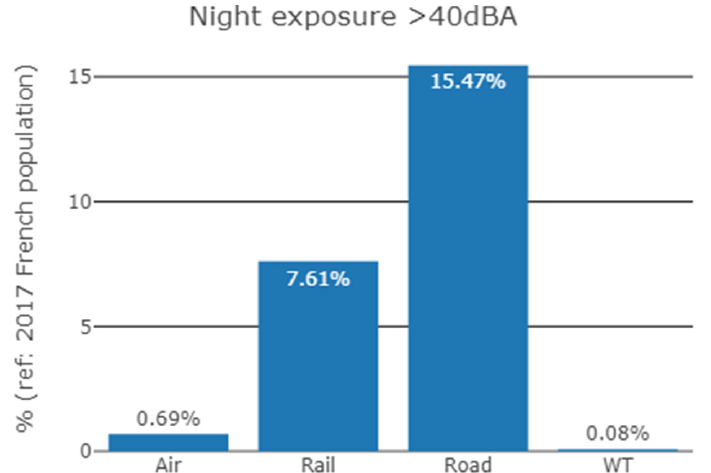
Figure 10. Proportion (%) of the 2017 French population exposed to sound levels above 40 dBA during the night, for four noise sources: aircraft noise (Air), railway noise (Rail), road traffic noise (Road) and wind turbine noise (WT).